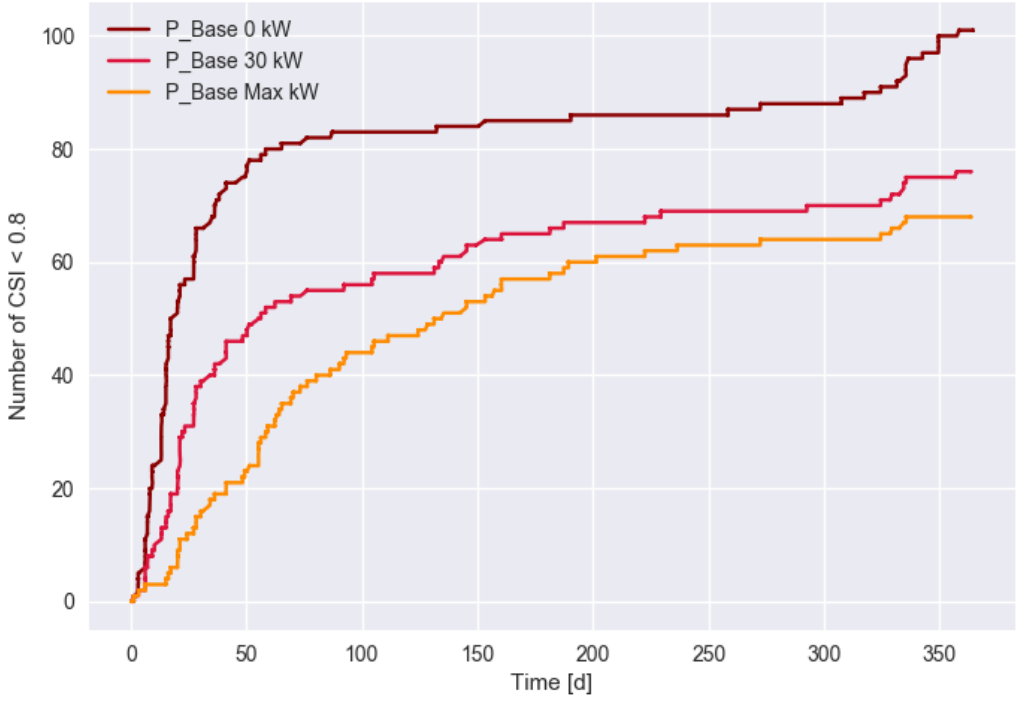
Figure 12. Accumulated number of low (<0.8) CSI charging processes in the CSI-sensitive scenario for different P Base